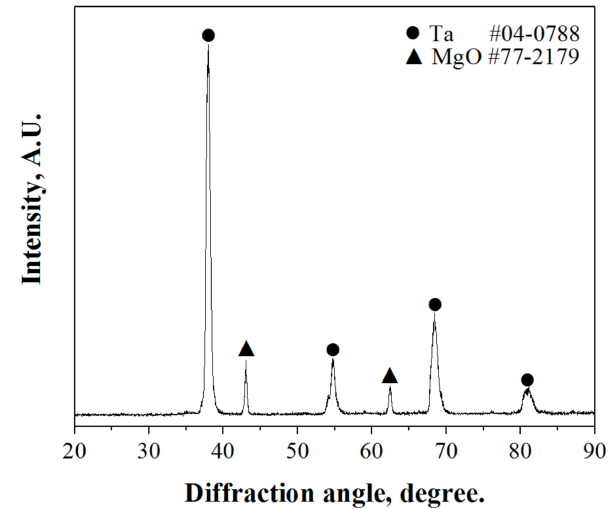
Figure 6. X-ray diffraction patterns measured in the Mg-reduced sample at 1173 K before acid leaching.